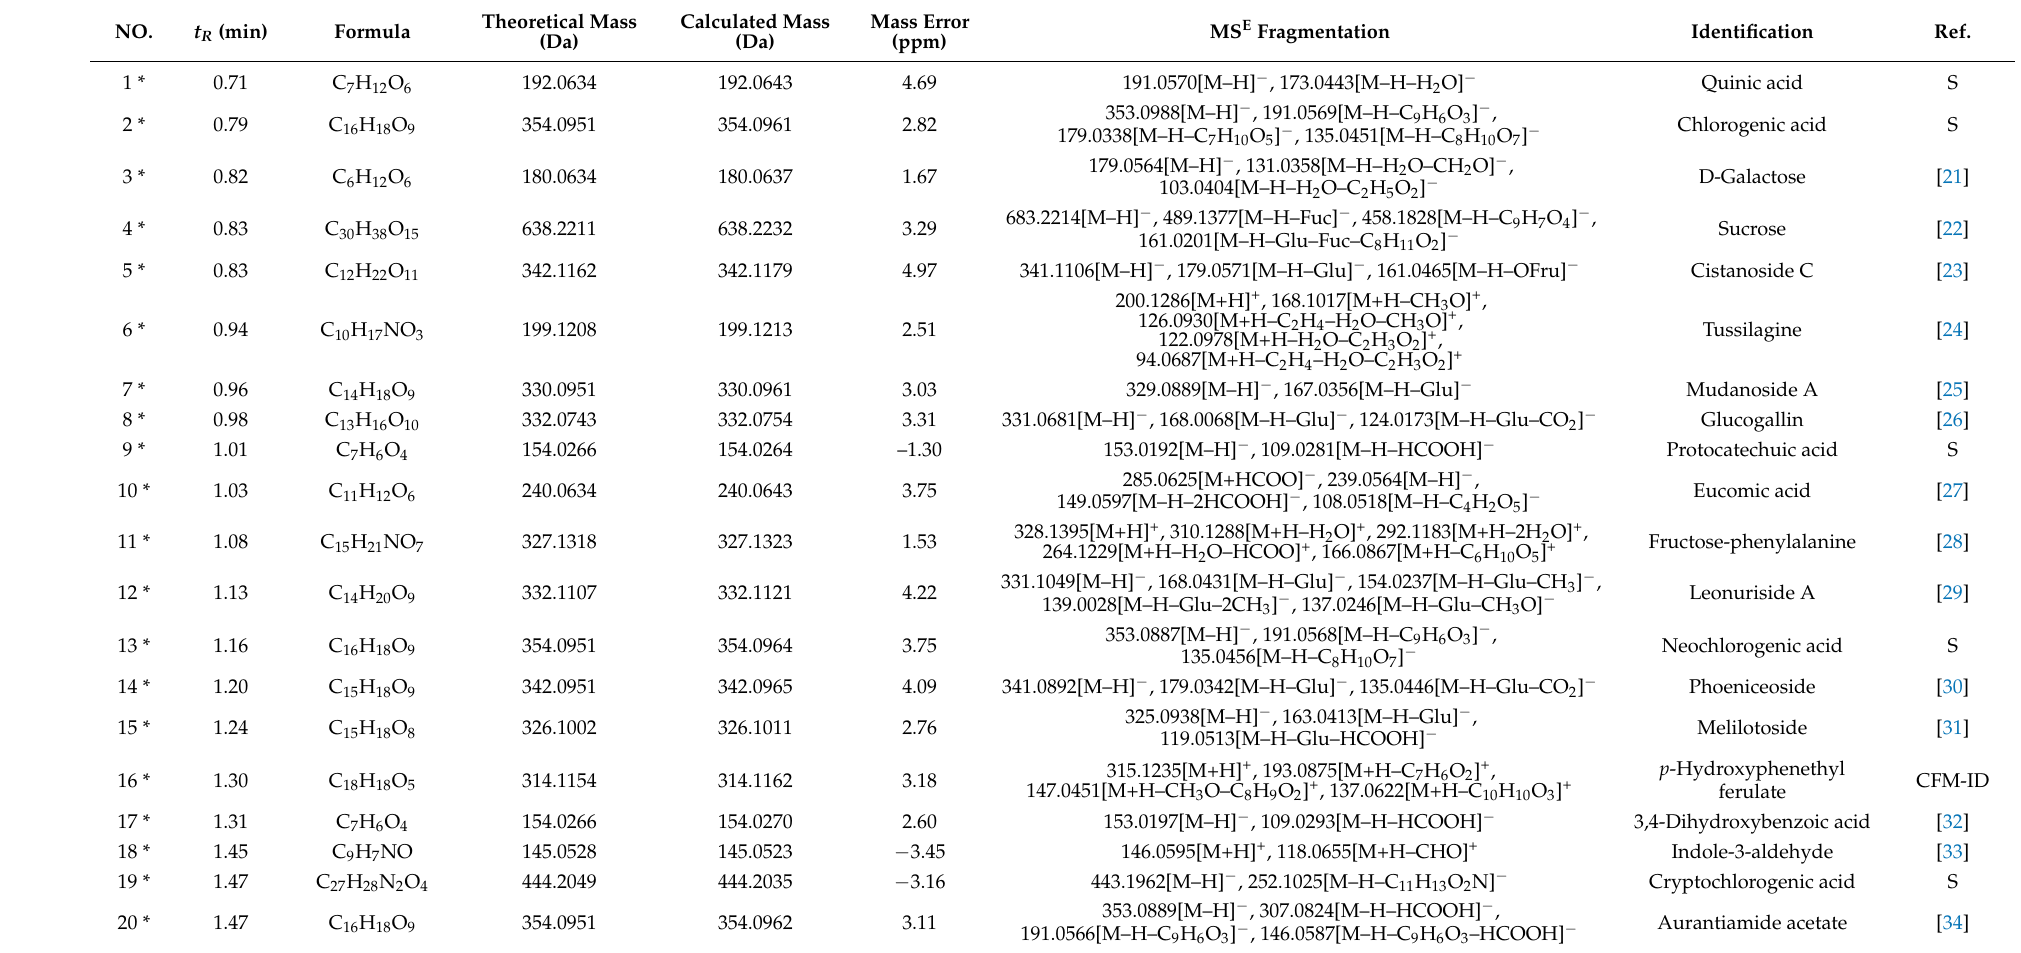
Table 1. Compounds identified from SP by